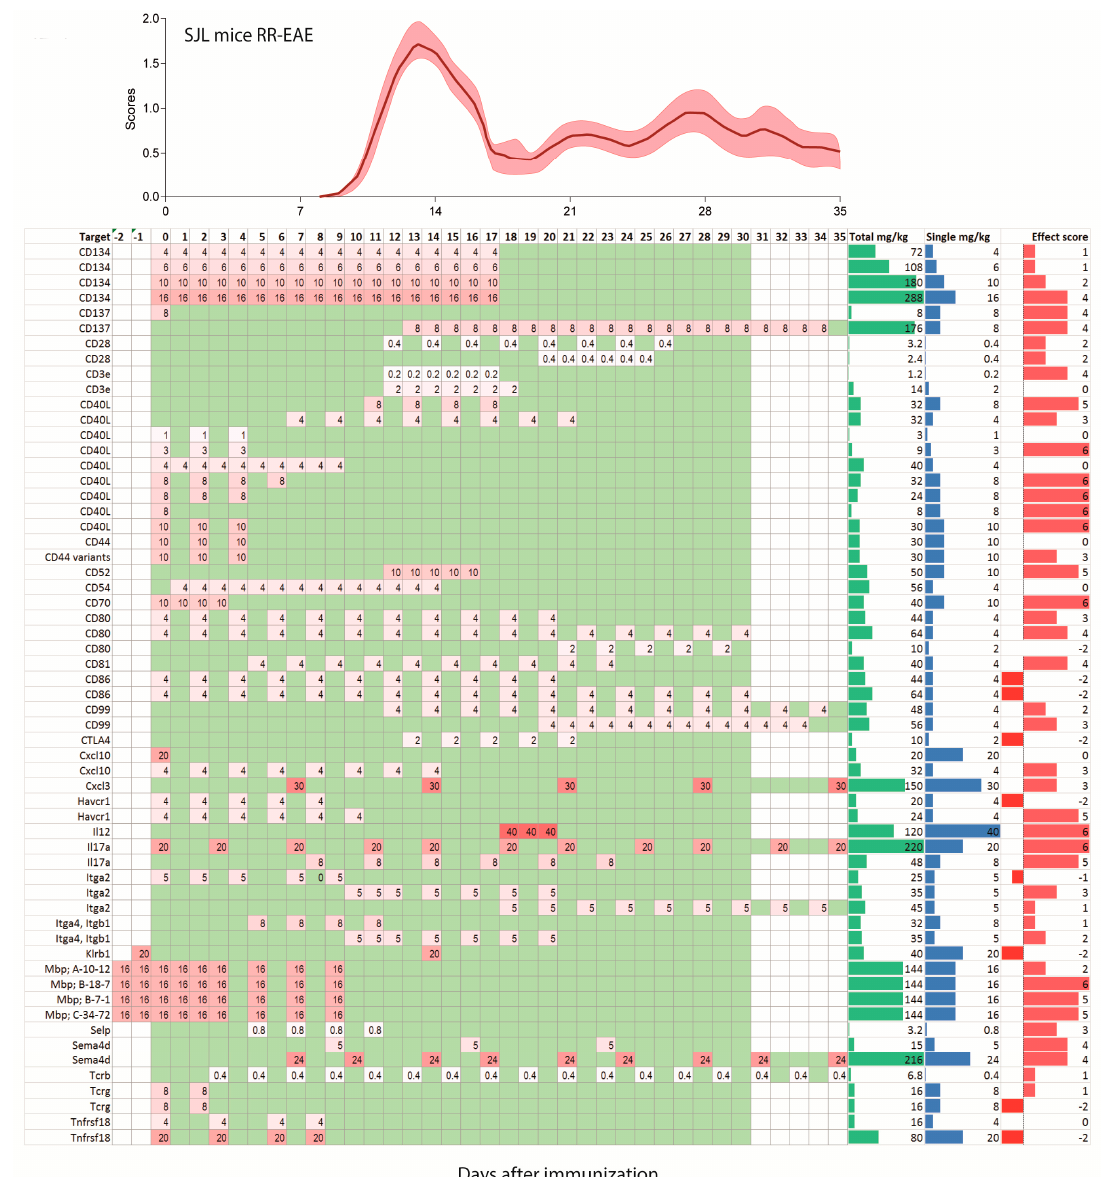
Figure 3. Treatment schedules with monoclonal antibodies in the SJL/J mouse model of relapsing- remitting EAE (RR-EAE) after active immunization on day zero. The schedules are aligned with the mean pooled EAE time course ± 95% confidence interval (red area) of 112 mice of our own studies. Mice were untreated or receiving placebo. The schedules range from − 3 days up to 35 days and are color-coded as in Figure 2. The darker the red, the higher was the single dose. Days without treatment are green, days without observation white. Two schedules with observation times > 35 days were cut.